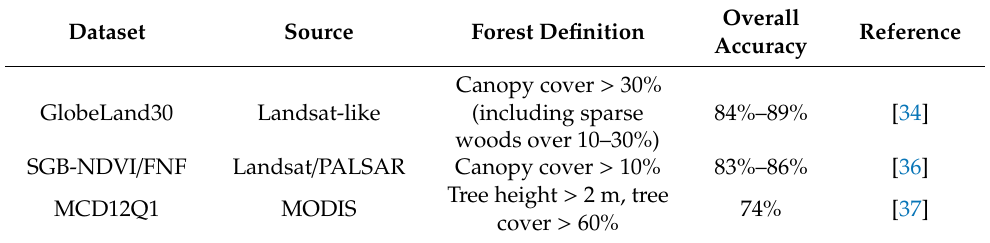
Table 1. Summary of di ff erent satellite-based land cover products used for forest cover change